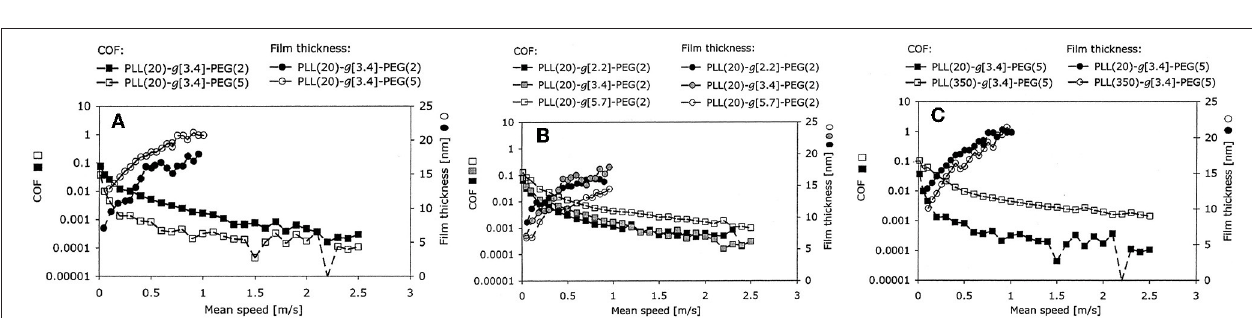
than that of the untextured SiC surface (Wang et al.,